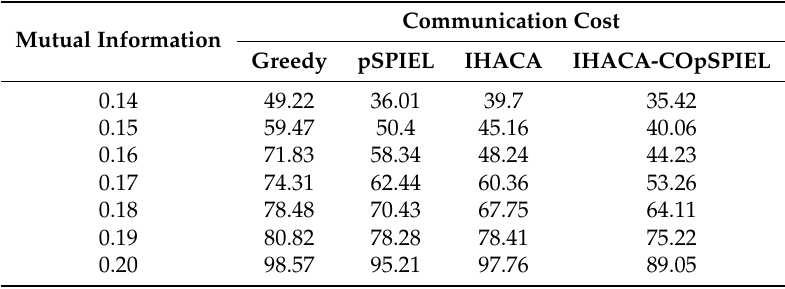
Table 2. Comparison of communication cost for the four